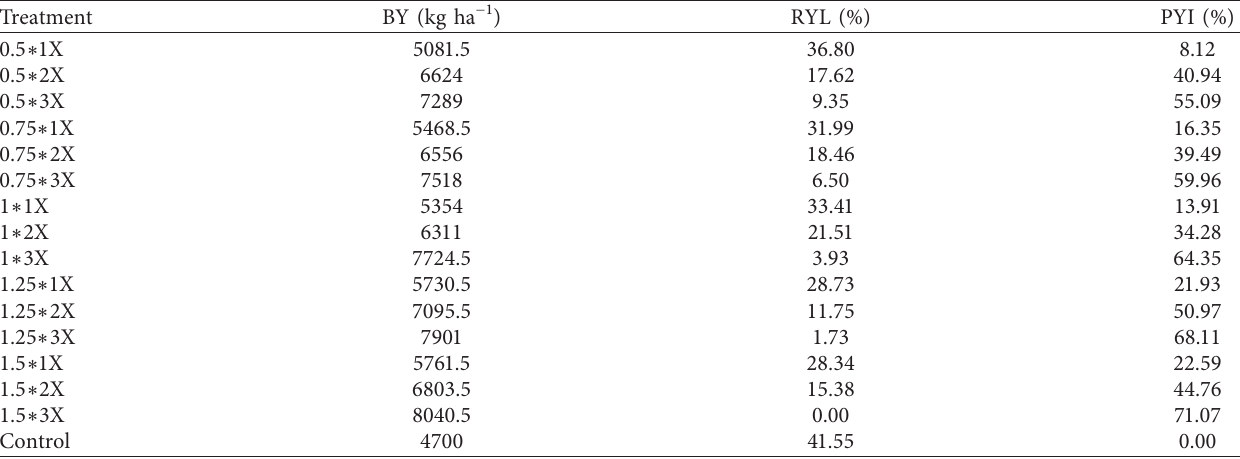
Table 6: Relative yield loss and percentage yield increase for both locations during 2019 cropping season.